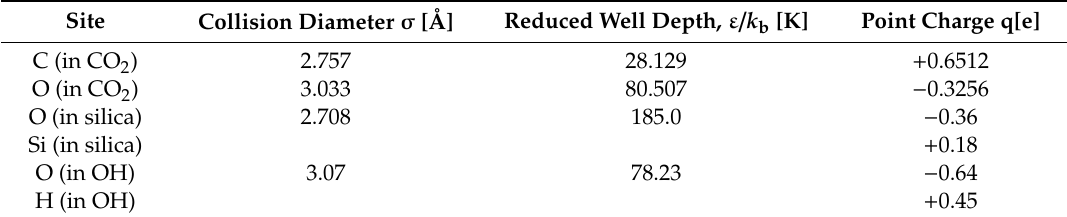
Table 1. Molecular parameters and partial point charges of CO 2 , SiO 4 and OH.